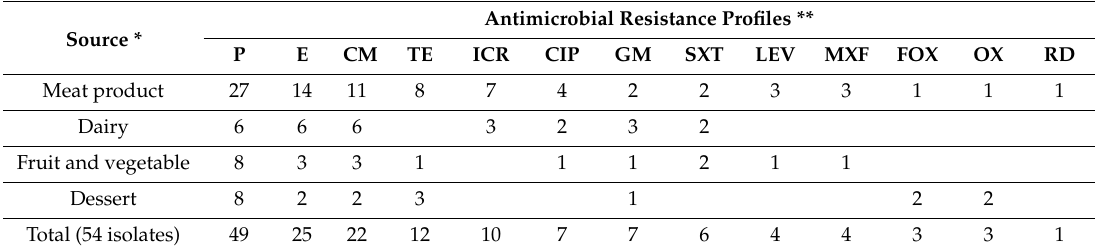
Table 4. Antimicrobial resistance profiles of S. aureus isolates from Ready-to-eat food in bulk (RTEIB foods), including meat, dairy, fruits and vegetables, and